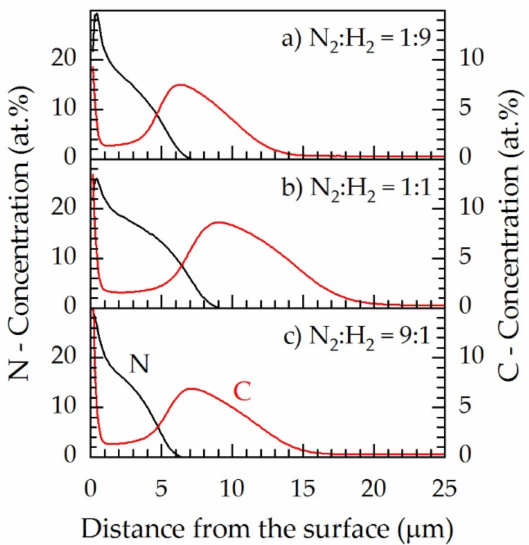
Figure 9. GDOES concentration–depth profiles of nitrogen (left axis, black) and carbon (right axis, red) for three feed gas compositions of ( a ) N 2 :H 2 = 1:9, ( b ) 1:1, ( c ) 9:1 at a fixed screen power of approximately 5 kW, T = 733 K; t = 5 h.